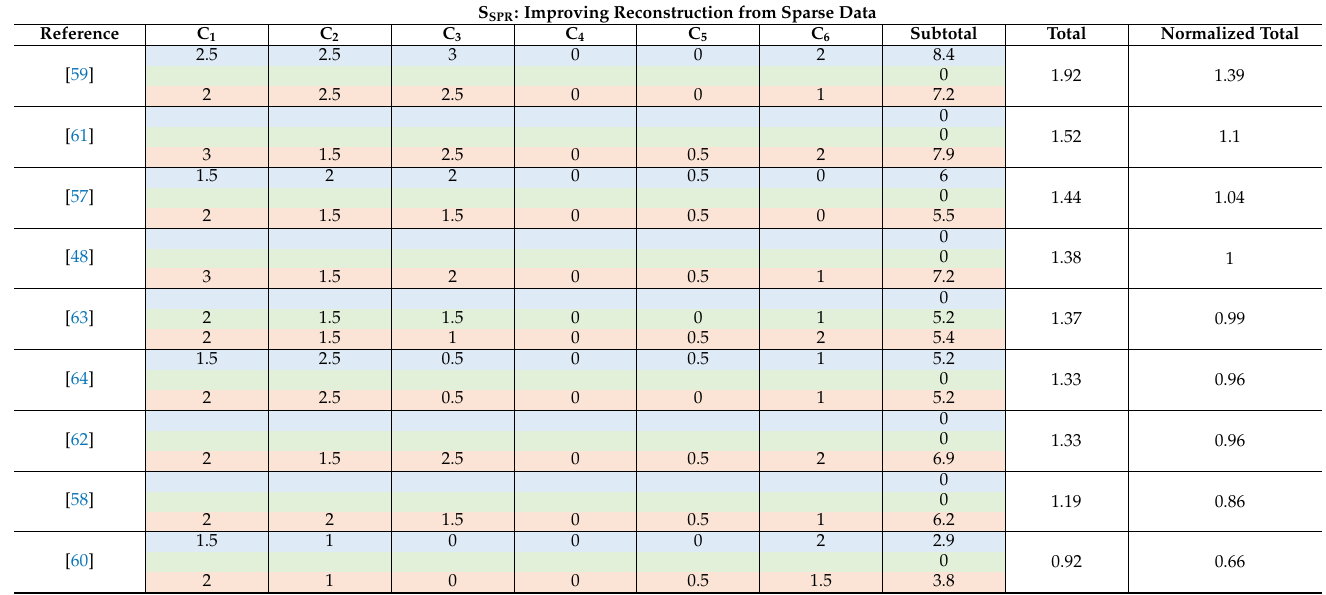
Table A1. Analytical ratings for all studies included in S SPR . The color in the table rows indicates the category of experiments as follows: numerical experiments , experiments with phantoms , and experiments with humans in vivo .